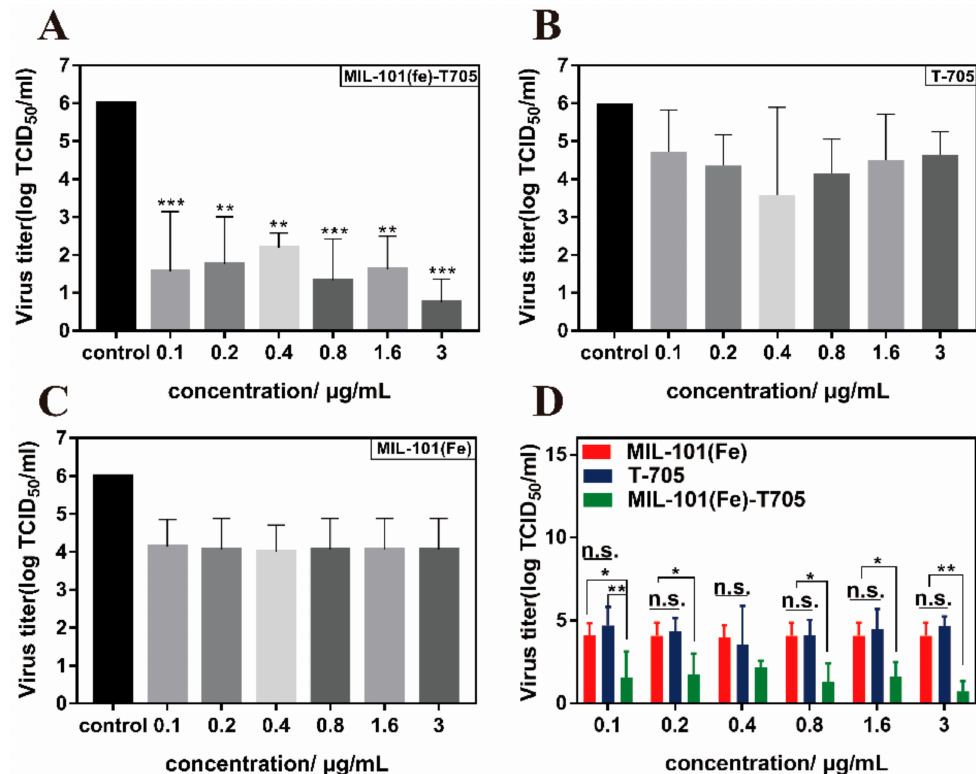
Figure 10. Changes in the titer of influenza virus. ( A ) Determination of H1N1 virus titer following treatment with varying concentrations of MIL-101 (Fe)-T705. ( B ) Determination of H1N1 virus T705. ( C ) Determination of H1N1 virus titers following treatment with varying concentrations of MIL-101(Fe). ( D ) Comparison of virus titers following treatment with varying concentrations of MIL-101(Fe)-T705, T-705, or MIL-101(Fe). * p < 0.05, ** p < 0.01, *** p < 0.001, and n.s. represents no significance. Data were mean ±